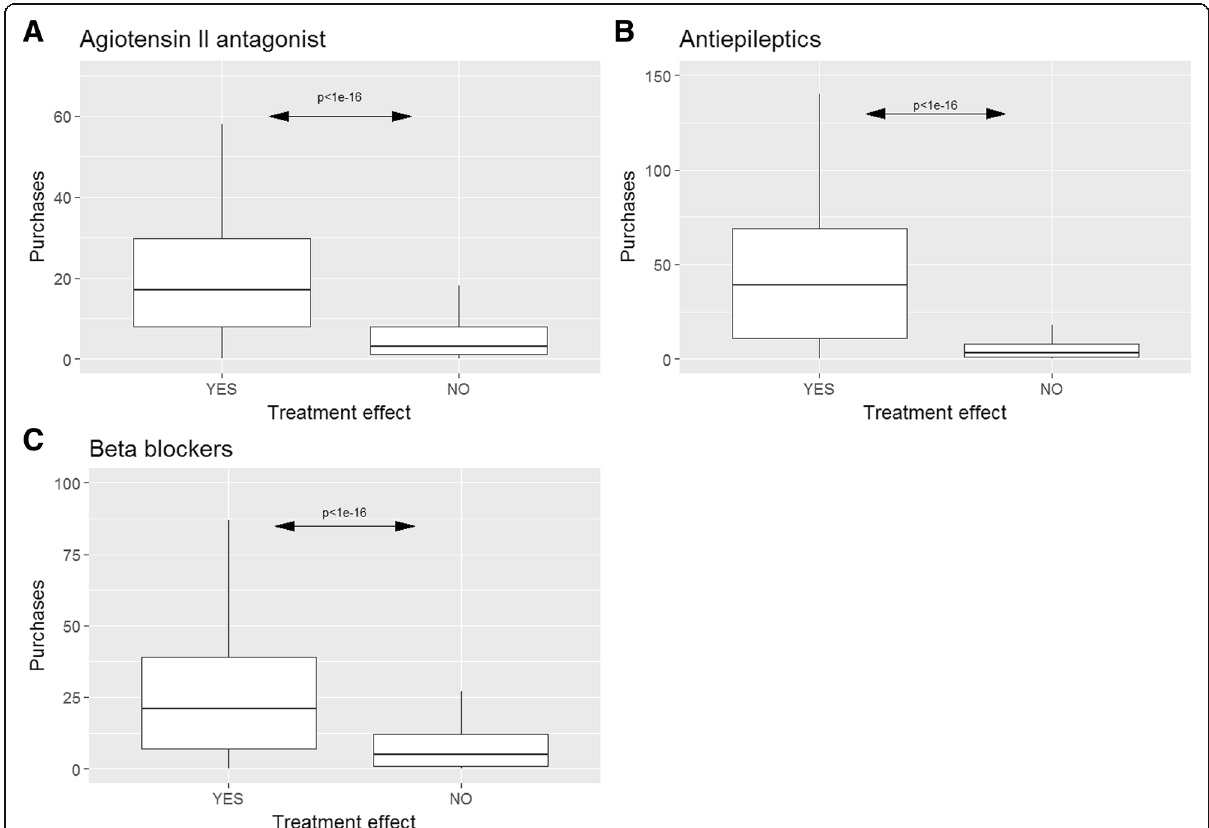
Fig. 3 Distribution of purchases of prophylactic treatment. The figure depicts the distribution of a ) Angiotensin II antagonist, b ) Antiepileptic,